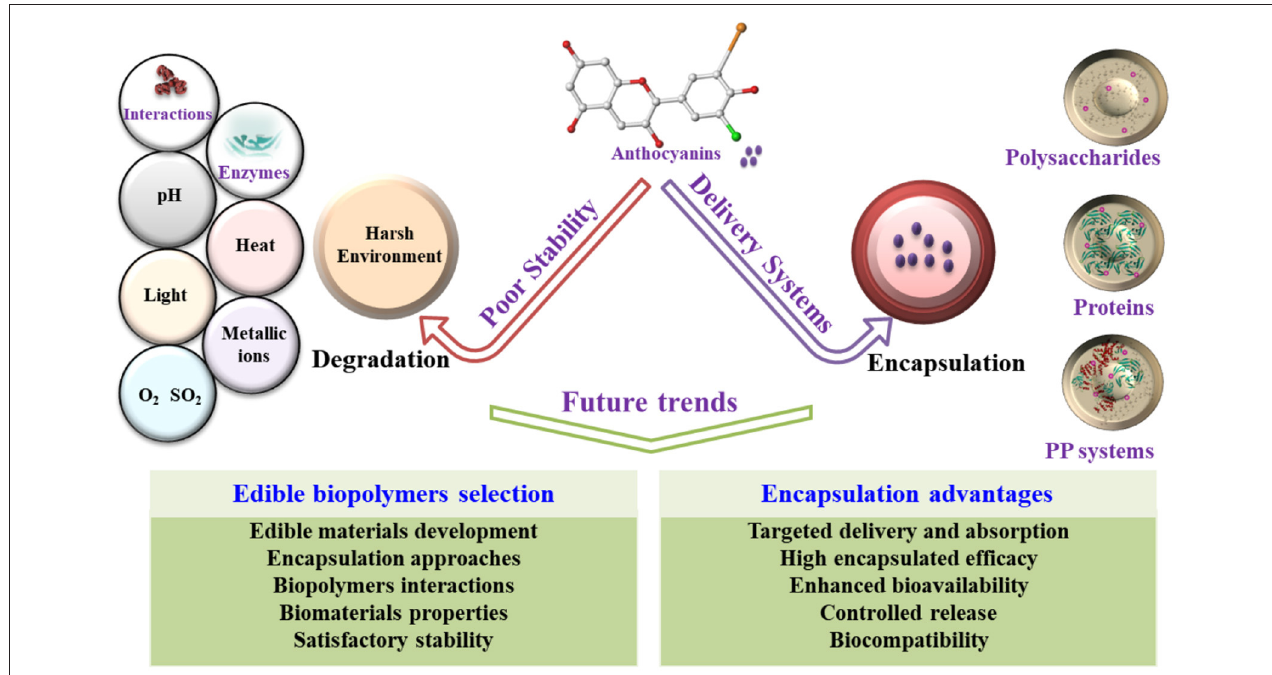
FIGURE 6 | Framework of the future trends or advantages of the micro-/nanoencapsulation of anthocyanins using edible biopolymers, including proteins or/and polysaccharides. PP,